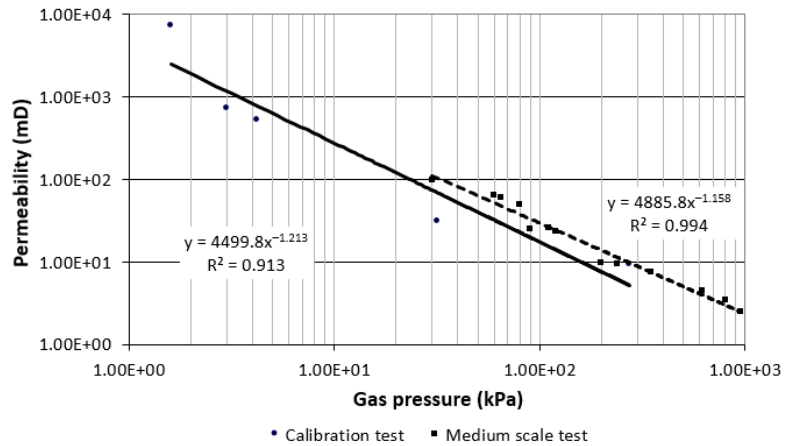
Figure 5. Pressure-permeability relationship in medium-scale tests and calibration tests.